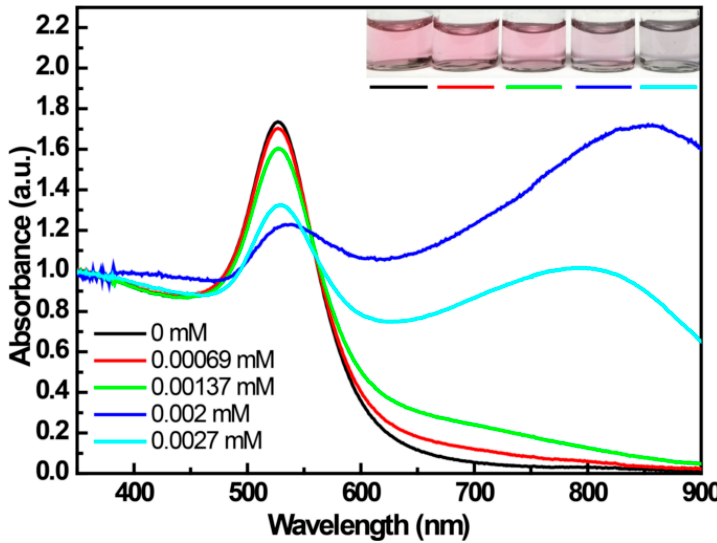
Figure 5. The change in the UV ‐ Vis spectrum of Mixt.4 with 4 ‐ hydroxythiophenol (4 ‐ HTP)